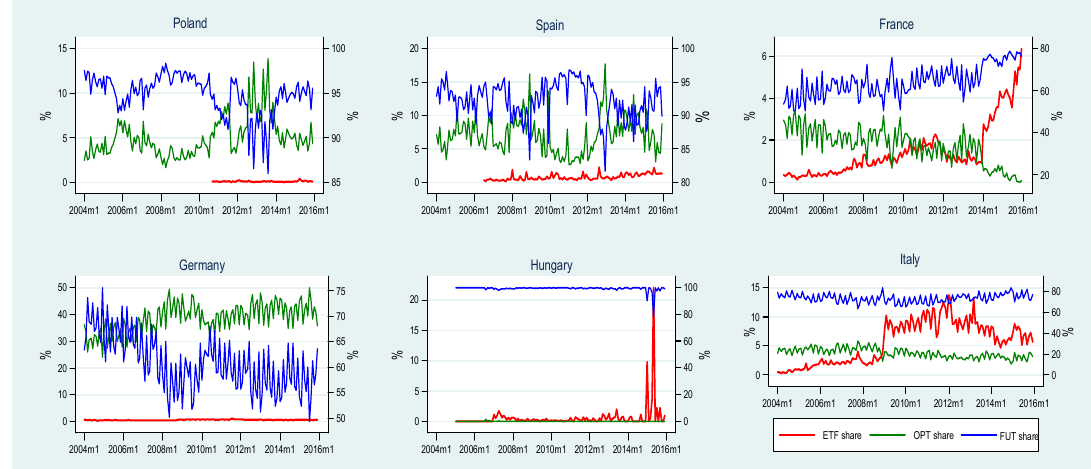
Figure 1. ETFs, stock index options and stock index futures—share of total turnover of index financial instruments. 2004–2015 (monthly time series). Left-hand Y axis—ETF share of total index financial instruments; right-hand Y axis—stock index options and stock index futures share of total index financial instruments.